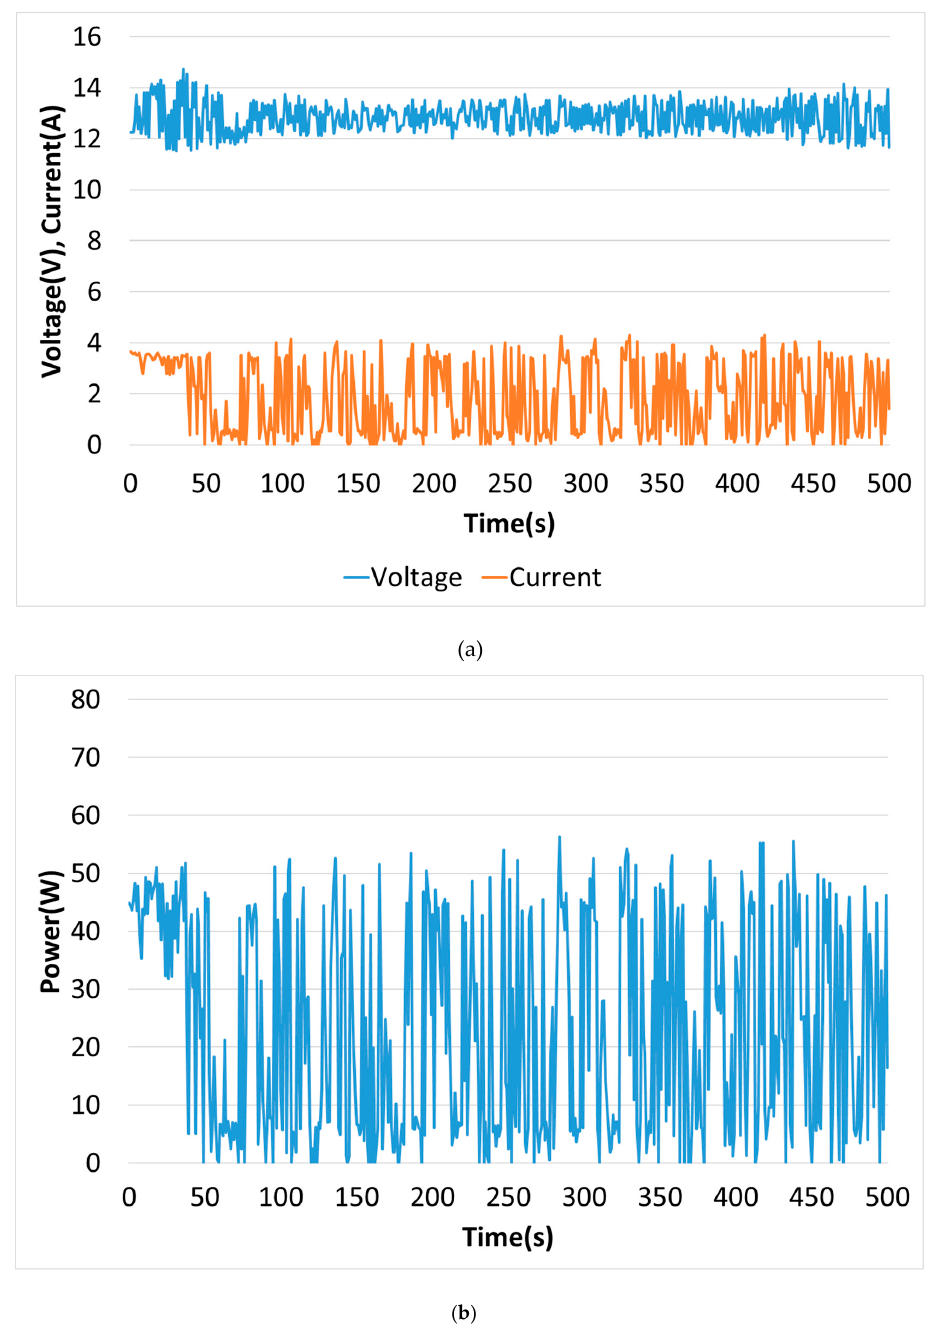
Figure 12. Voltage, Current, and Power of PI controller. ( a ) Voltage and Current. ( b ) Power.